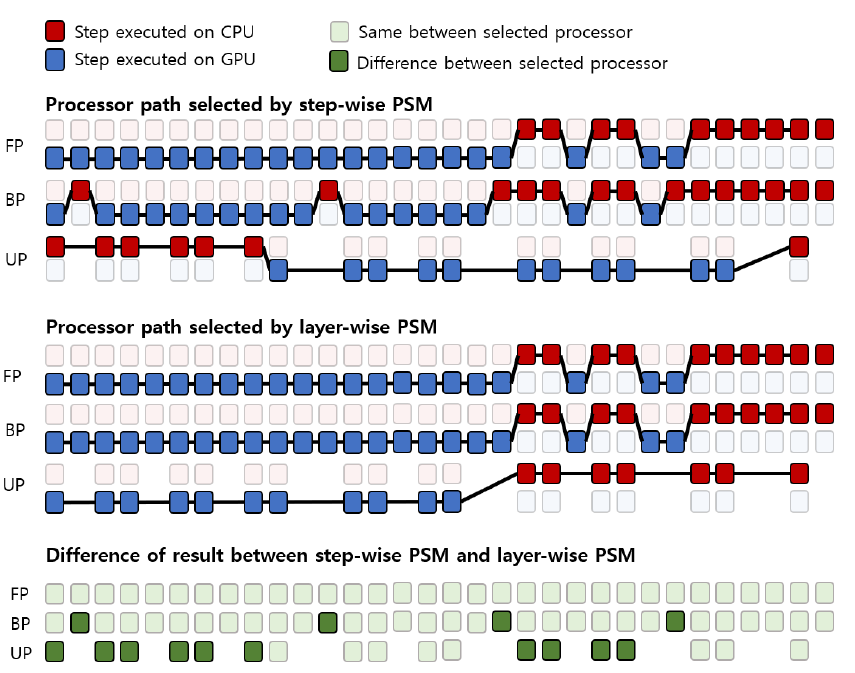
Figure 8. The results of the processor path being selected by step-wise PSM and layer-wise PSM per step, and the difference of selected processor between by step-wise PSM and by layer-wise PSM.